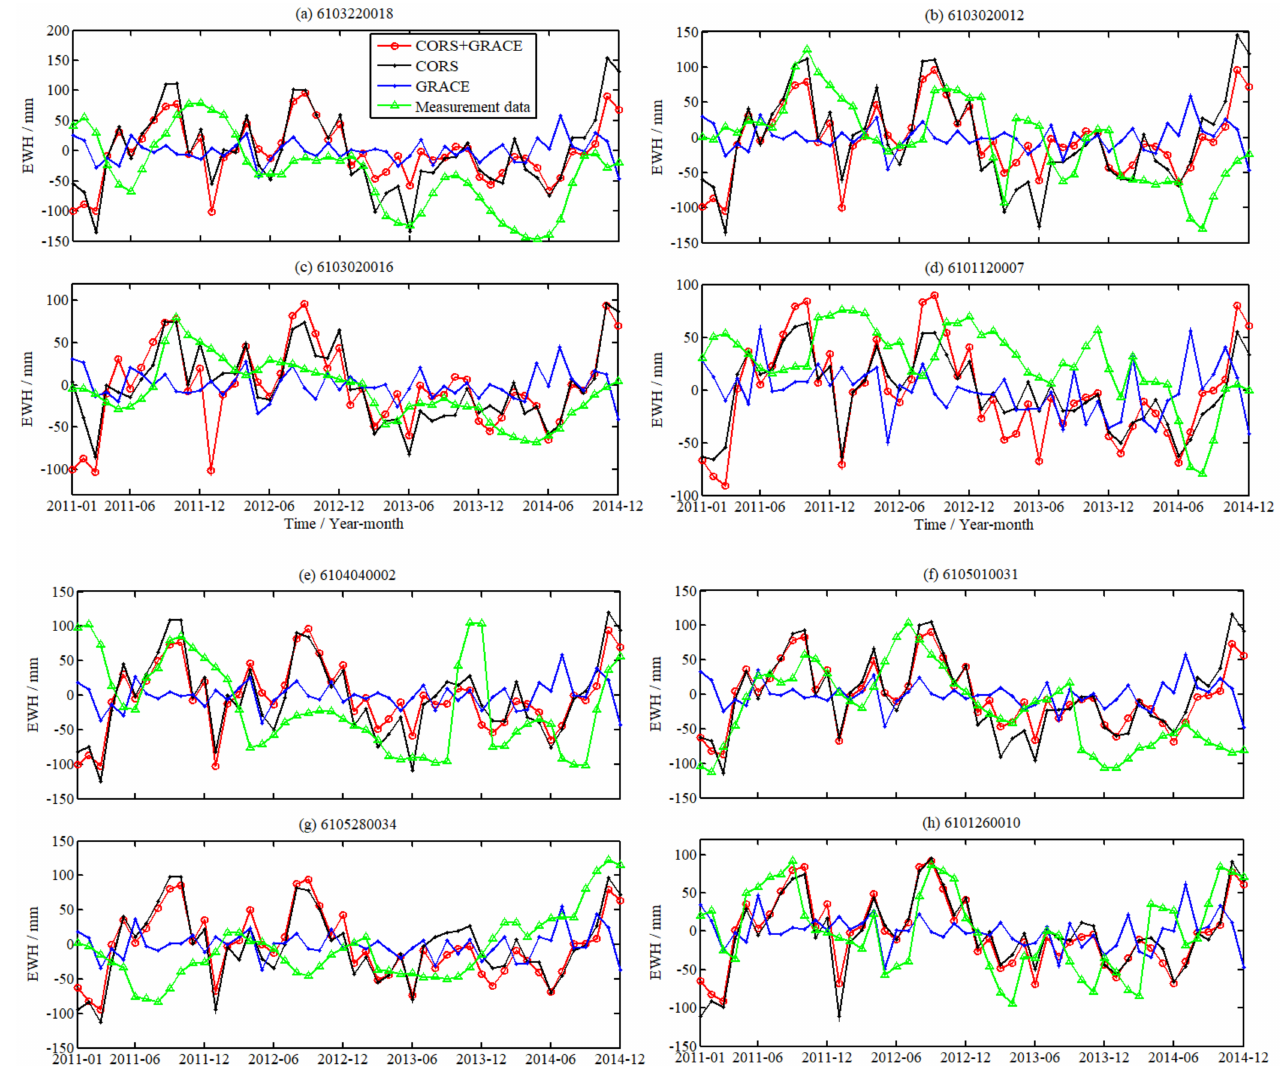
Figure 15. Comparison of three kinds of inversion results with in situ groundwater level